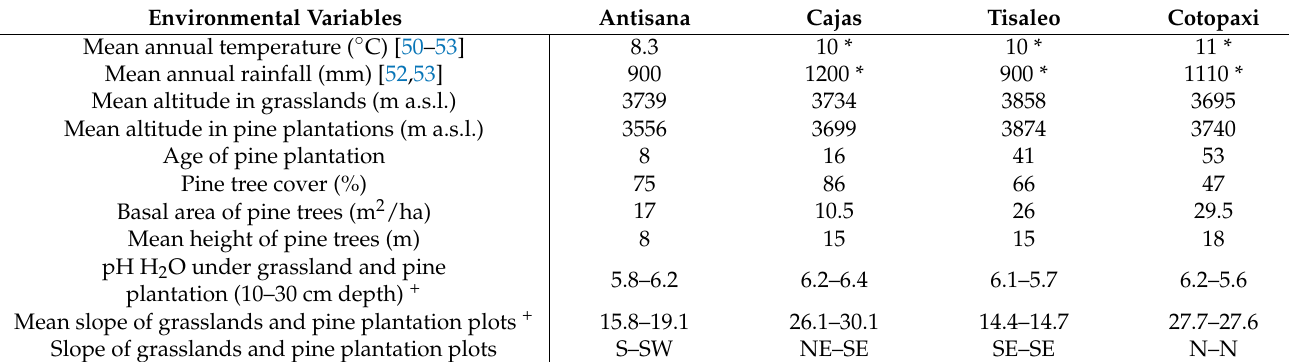
Figure 1. Location of the study zones with both land uses, pine plantations and grasslands. Co- ordinates system: World geodetic system 84 (degrees and minutes). (Ant = Antisana, Caj = Cajas, Tis = Tisaleo, Cot = Cotopaxi, G = Grassland and P = pine plantation). Table 1. Climate, soil and stand characteristics of the four study